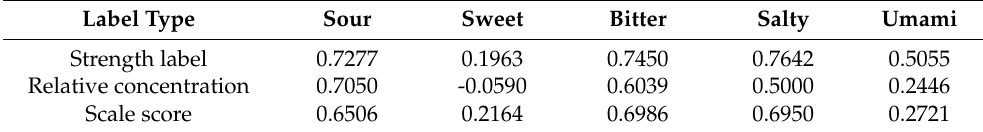
Table 4. Regression result ( R 2 scores) for different taste types and label